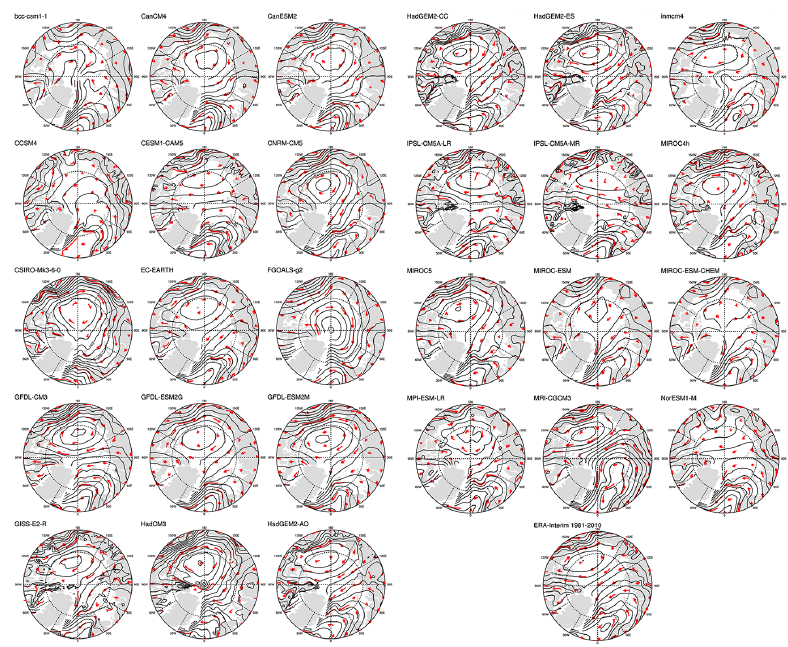
Figure 6. Mean annual sea level pressure and geostrophic wind from 27 CMIP5 models and from ERA-Interim spanning 1981–2010. Contour interval is 1hPa. Near-surface geostrophic wind is used as a proxy for sea ice motion and is shown by red vectors. Vector length is proportional to wind speed. Vectors are curved tangents to the instantaneous